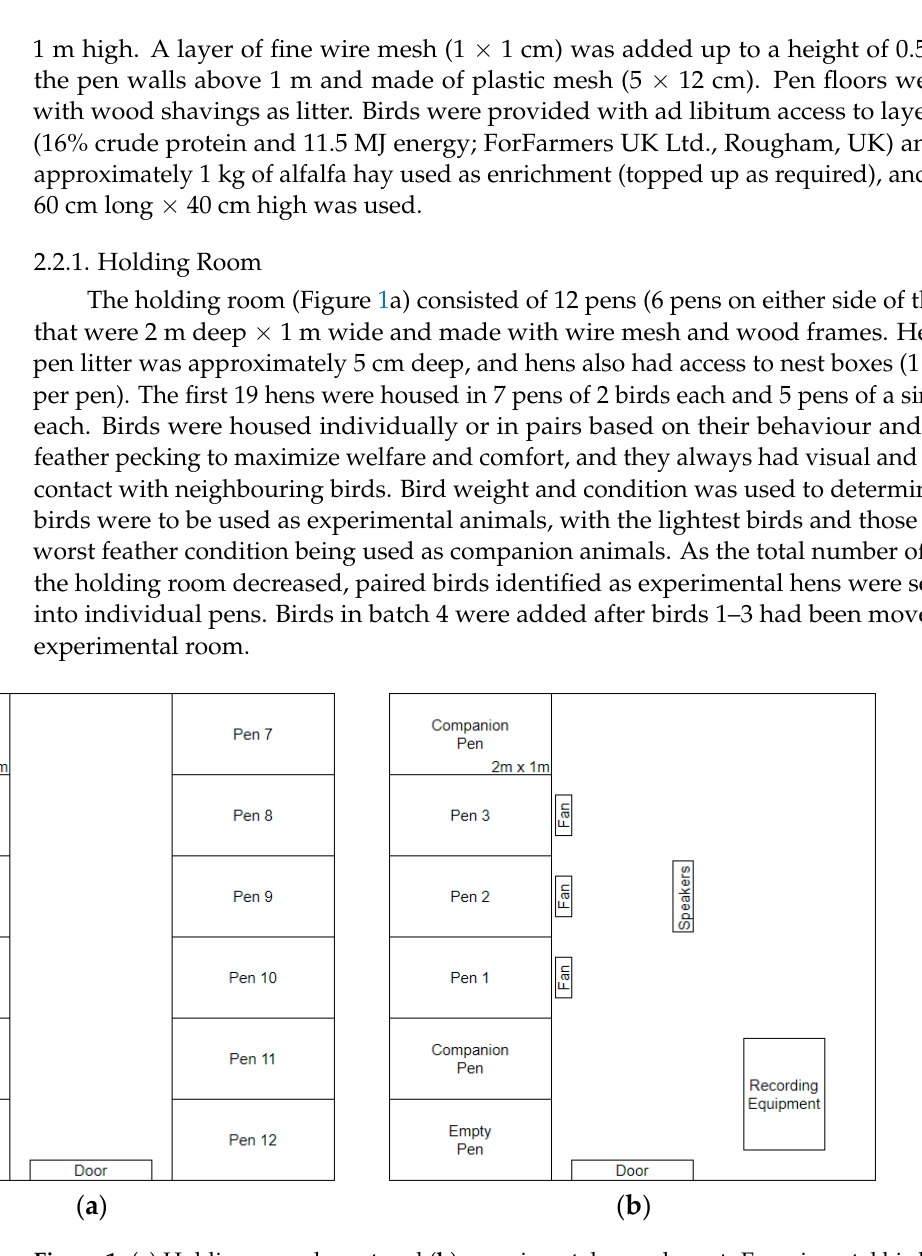
Figure 1. ( a ) Holding room layout and ( b ) experimental room layout. Experimental birds were in groups of 3 (e.g., birds 1–3, birds 4–6, etc.) at a time.